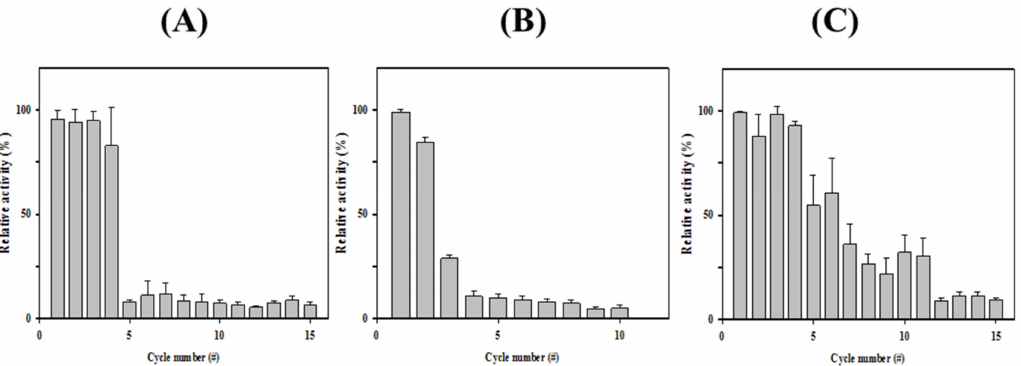
Figure 7. Reusabilities of immobilized Ha HSL. The reusability of CLEA-Arg- Ha HSL ( A ), mCLEA-Arg- Ha HSL ( B ), and hNF- Ha HSL ( C ) were investigated. All assays were performed at least in